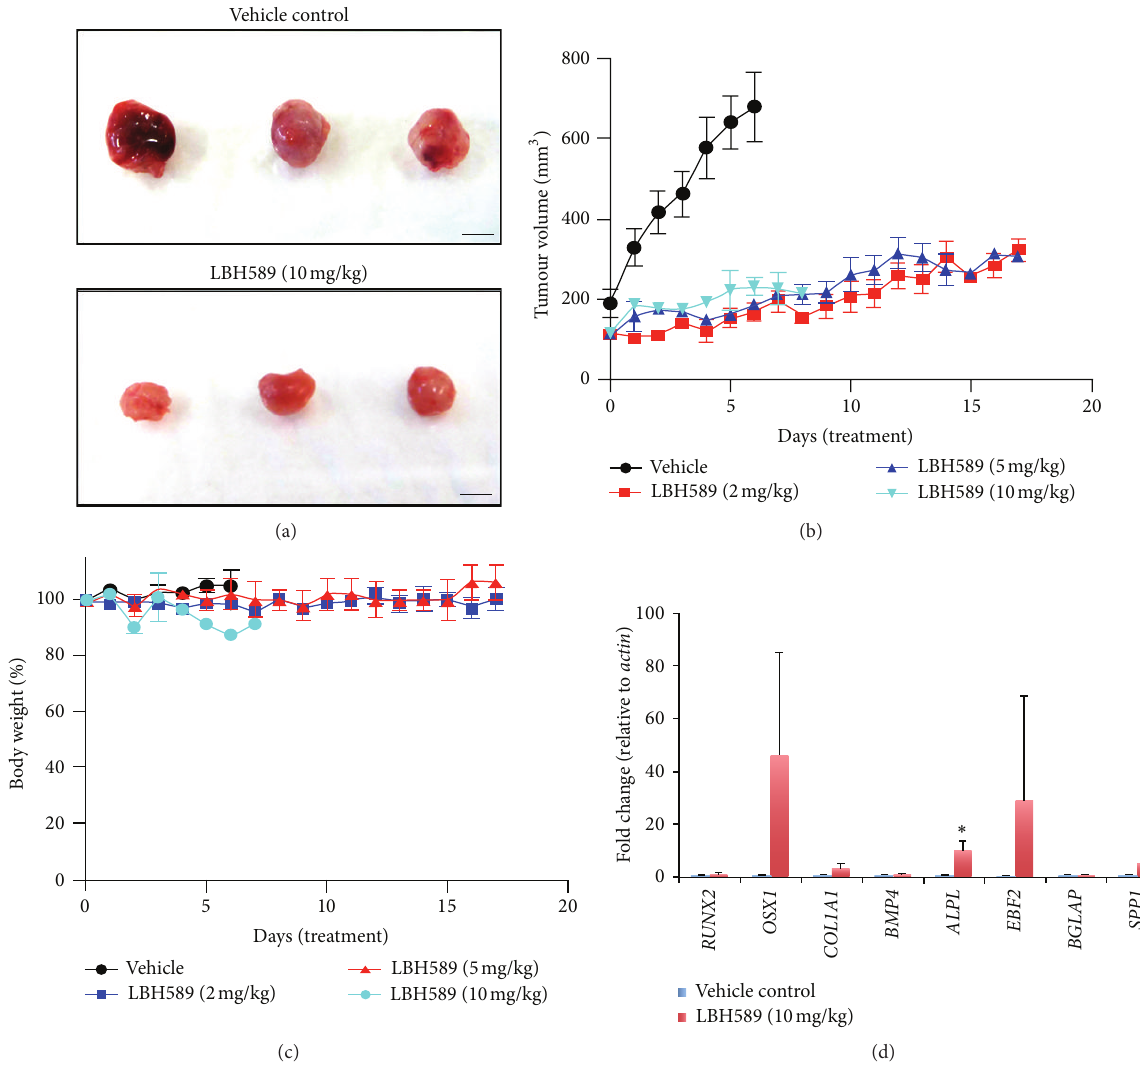
Figure 4: LBH589 reduces osteosarcoma tumour growth and drives osteoblast differentiation in vivo . (a) U2OS xenograft flank tumours treated with vehicle control or 10mg/kg LBH589 i.p. daily for 6 days. Bar = 5 mm. (b) Tumour volume. Mean ± SEM. (c) Percentage body weight. Mean ± SEM. (d) Quantitative real-time PCR of U2OS xenograft tumours following 6 consecutive days of treatment with vehicle control for expression of osteoblast differentiation markers. ∗ 𝑃 < 0.05